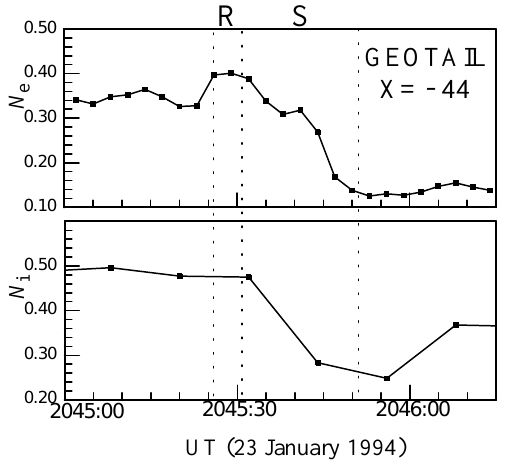
Fig. 8. The plots of the 3 s electron number density N e and the 12 s average ion number density N i show that the plasma density increases monotonically inside the S-layer, and remains nearly un- changed through the R-layer.